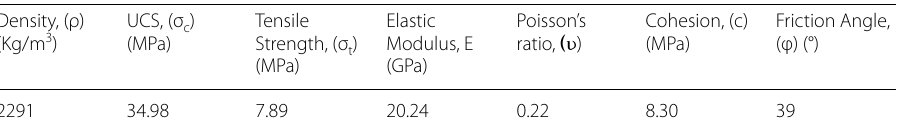
Table 1 Intact rock properties Density, (ρ) (Kg/m 3 )